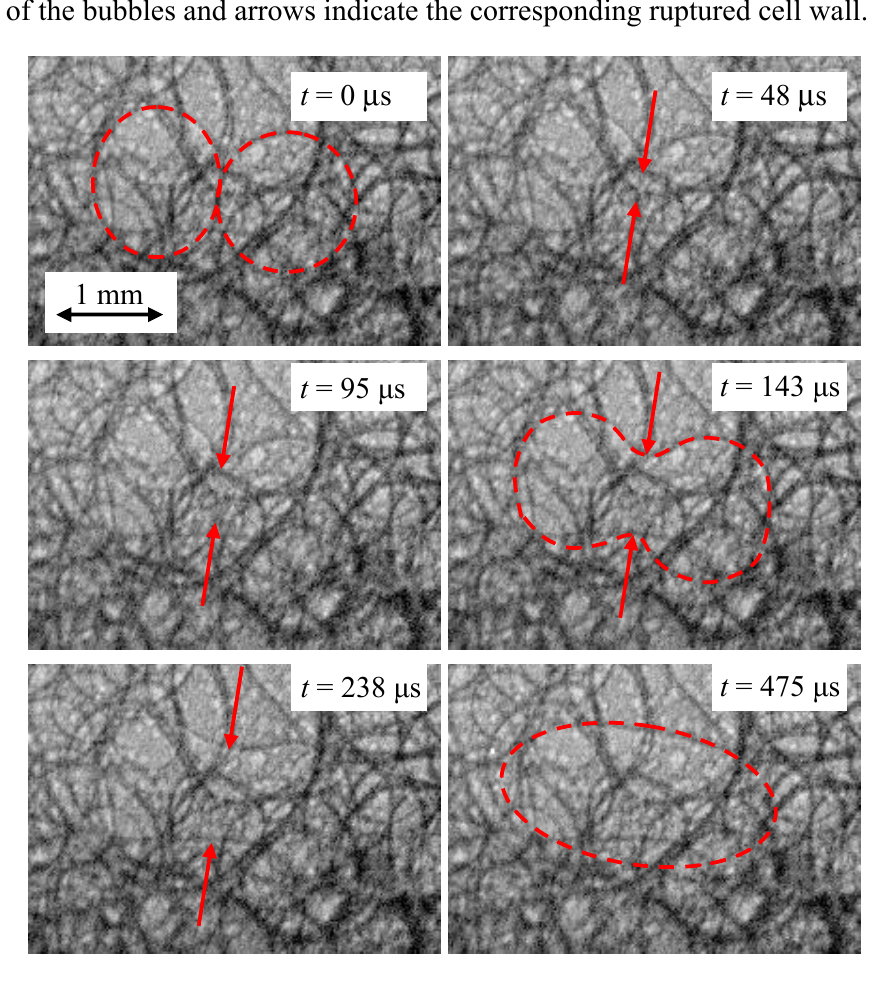
foam at 640 °C extracted 2